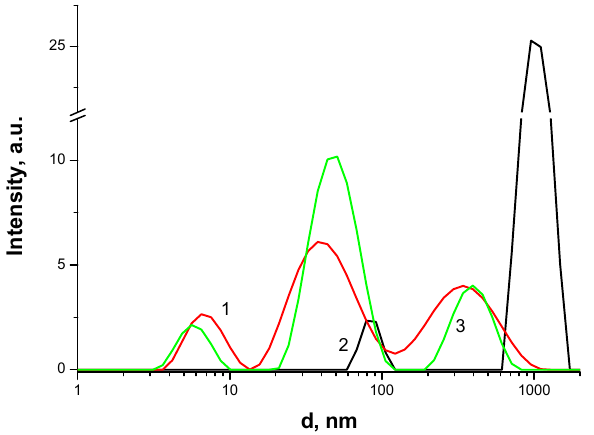
Figure 8. Size distribution of associates of TPPF20-F127 (1), CT 100 (2), TPPF20-F127-CT 100 (3) in aqueous and acetic acid solutions. The concentration of porphyrin C = 5 × 10 − 6 M, the concentration of CT 100 is 0.05 mass% and concentration of F127 is 1 mass%.